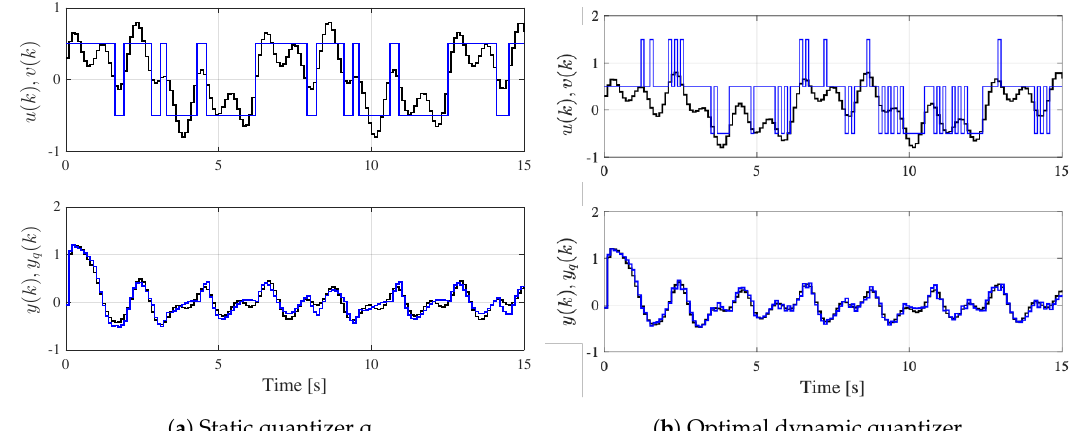
Figure 10. Signals resulting from applying u ( k ) to the systems with the static quantizer q in Figure 3 and the optimal dynamic quantizer proposed in [5]. The black lines represent the signals without quantization ( u ( k ) , y ( k ) ) and the blues ones are the signals when quantization is applied ( v ( k ) , u q ( k ) , y q ( k )